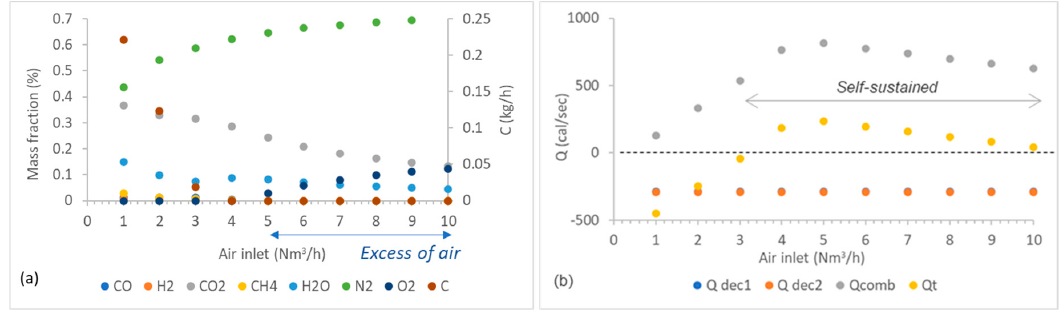
Figure 11. Mass ( a ) and energy ( b ) balances for the co-incineration of 20 g mixture / min.